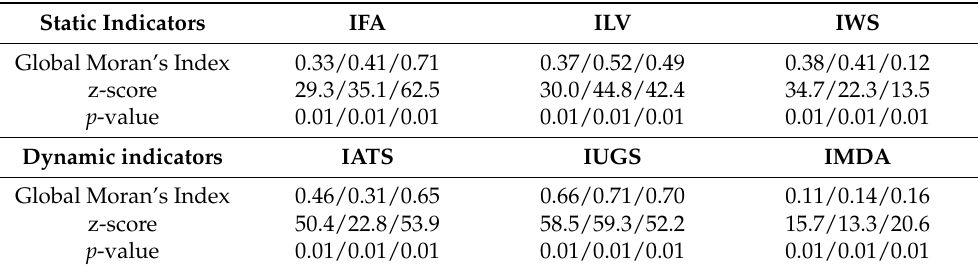
Table 3. Global Moran’s I statistic for static and dynamic indicators in the three case studies (data order: Doñana Park/Tablas de Daimiel/Albufera of